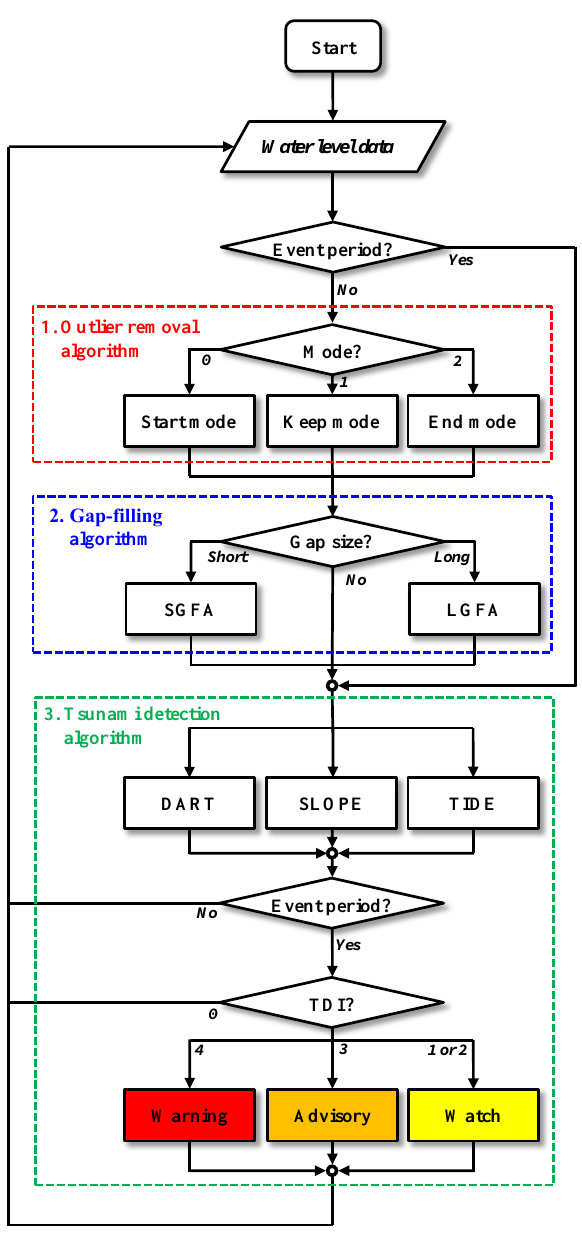
Figure 3: Flow of the TADS (Tsunami Arrival time Detection System). The system is composed of three major algorithms: outlier removal (red dotted box), gap filling (blue Figure 3. Flow of TADS. The system is composed of three major dotted box) and tsunami detection (green dotted box). SGFA stands for Short Gap Filling algorithms: outlier removal (red dotted box), gap filling (blue dotted Algorithm; LGFA stands for Long Gap Filling Algorithm; TDI stands for Tsunami box), and tsunami detection (green dotted box). SGFA stands for Detection Index. Short Gap-Filling Algorithm; LGFA stands for Long Gap-Filling Algorithm; TDI stands for Tsunami Detection